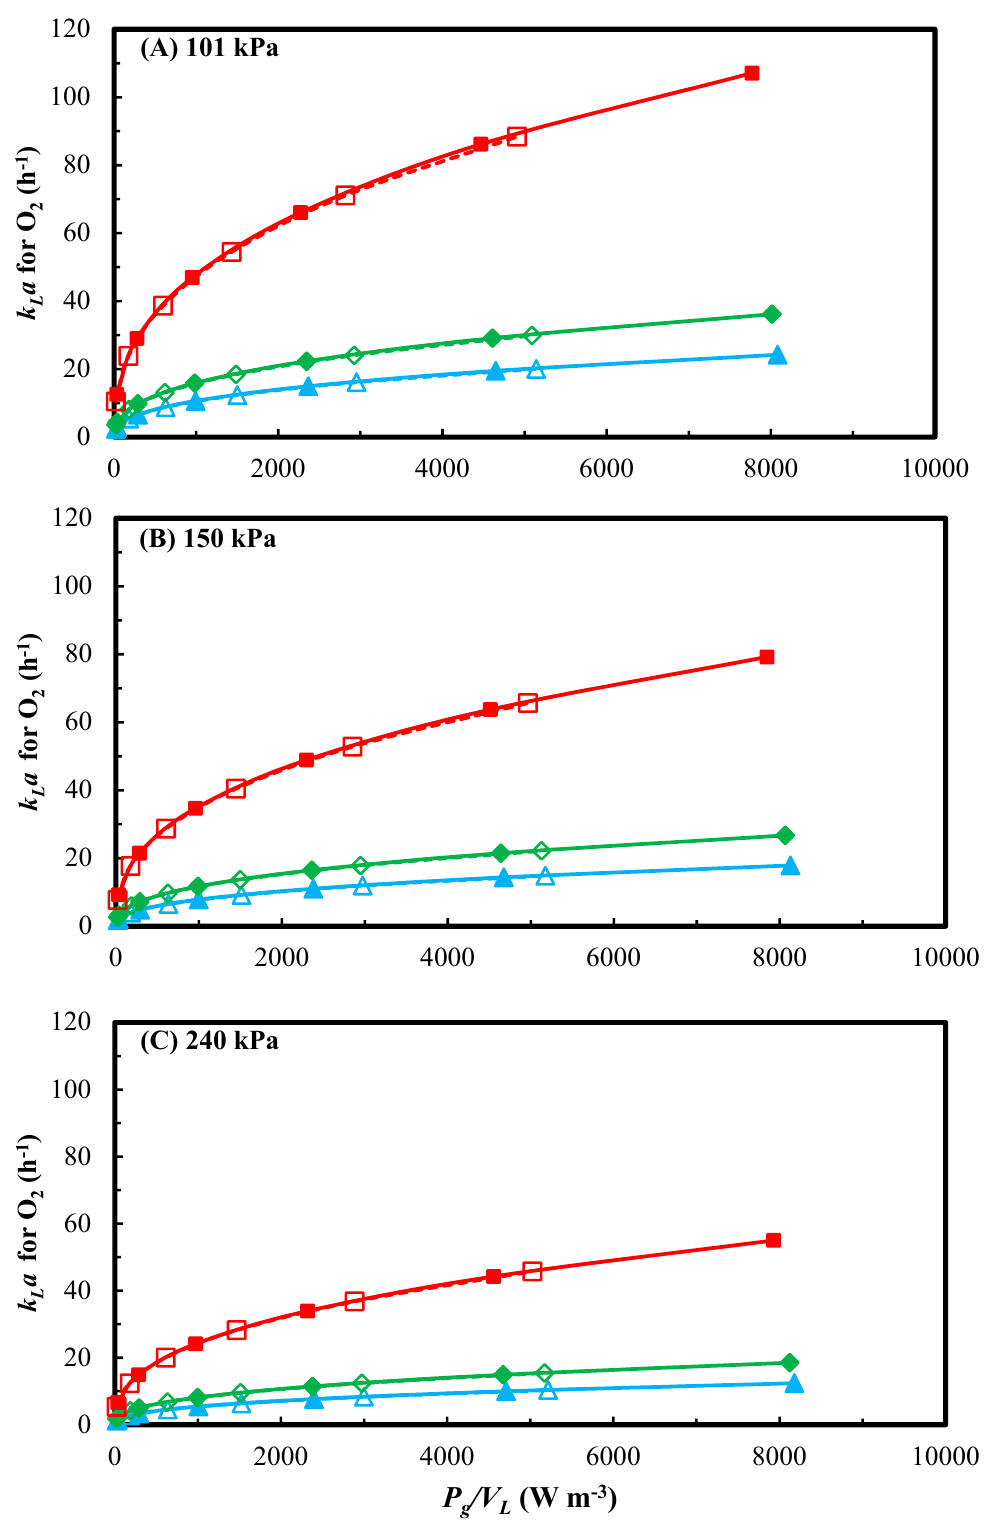
Figure 6. Profiles of predicted k L a for O 2 with P g / V L at various headspace pressures (A) 101 kPa (B) 150 kPa (C) 240 kPa and 90 sccm ( ▲ ), 150 sccm ( ♦ ) and 600 sccm ( ■ ) in 3 L working volume (solid symbol and solid line) and 5.6 L working volume (open symbol and dash line).